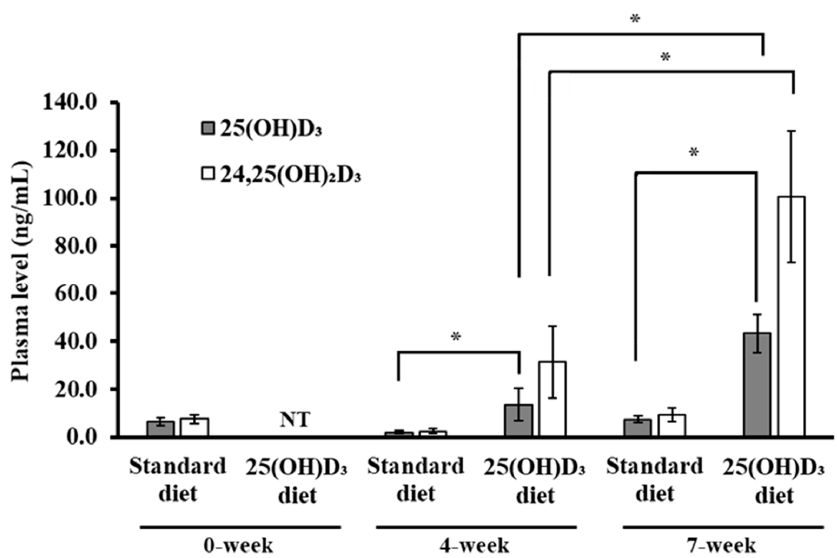
Figure 2. Plasma levels of 25(OH)D 3 and 24,25(OH) 2 D 3 in mice. Mice were fed a standard or a 125 ppm 25(OH)D 3 -supplemented diet for 7 weeks. The levels of 25(OH)D 3 and 24,25(OH) 2 D 3 were measured in each group (6 mice/group) at weeks 0, 4, and 7. Blood concentrations of 25(OH)D 3 and 24,25(OH) 2 D 3 in the 25(OH)D 3 -fed group at week 0 were not tested (NT). *, significant difference ( p < 0.05).